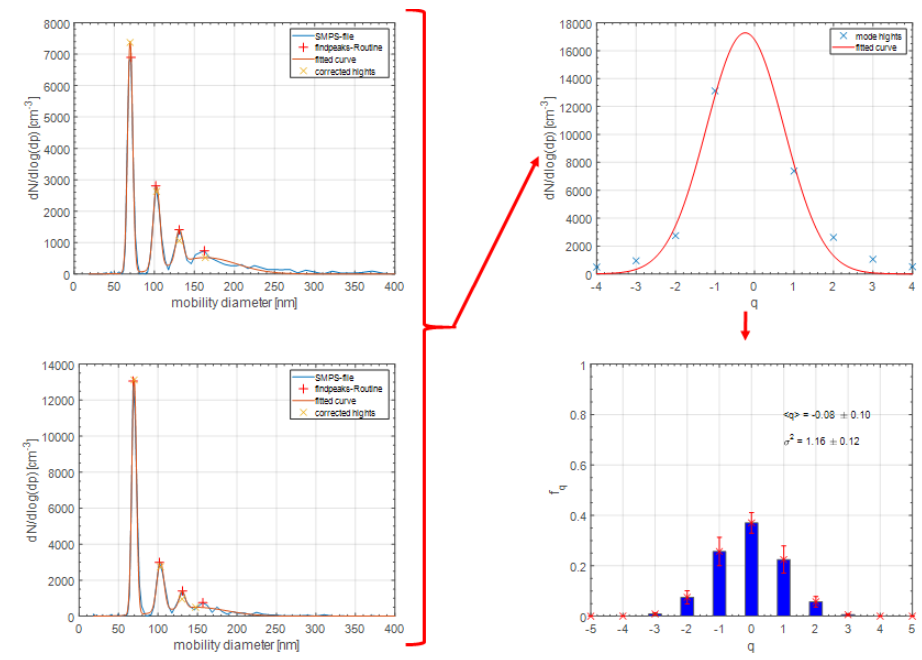
Figure A1. Determination of charge distribution on monodisperse particles based on mobility spectra, measured by a tandem DMA